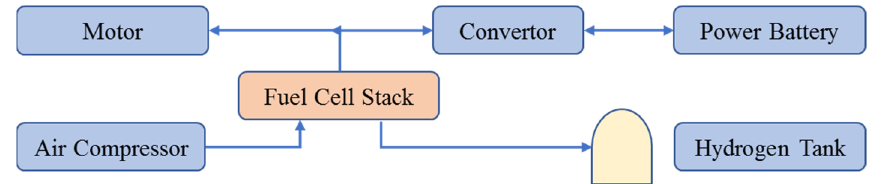
Table 1. Layout, types, and parameters of the studied power battery packs.